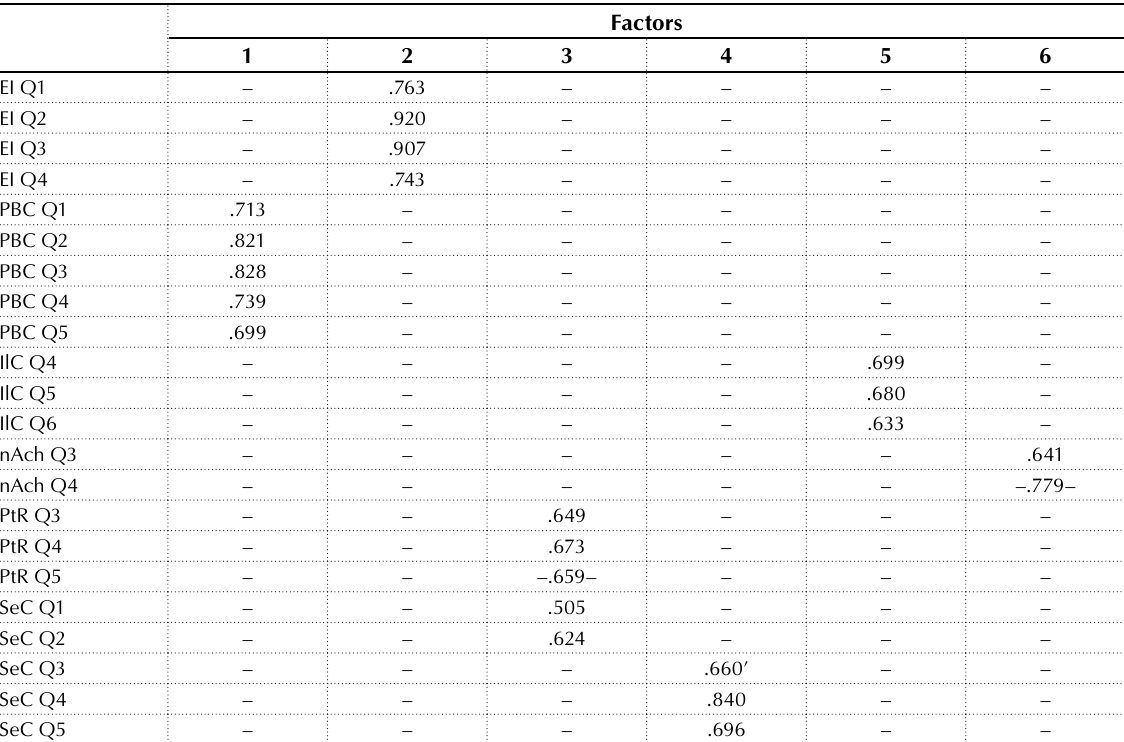
Table 3. Pattern matrix